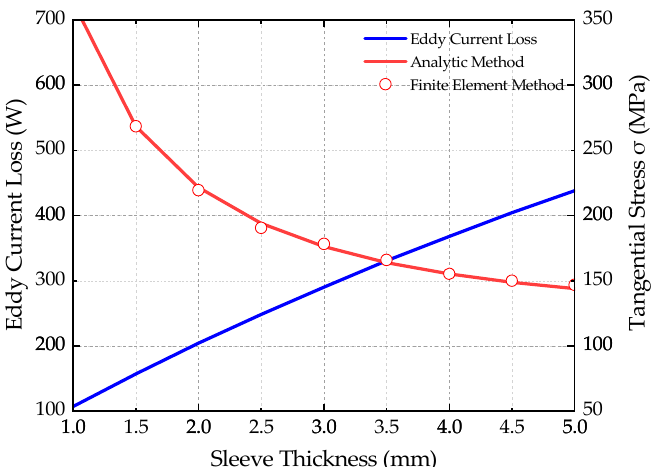
Figure 7. Results of rotor eddy current loss and rotor strength analysis with different thickness by FE.